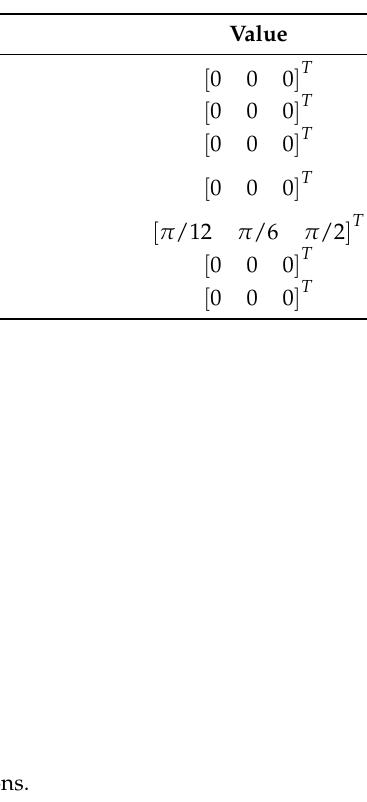
Table 3. Simulation initial values.